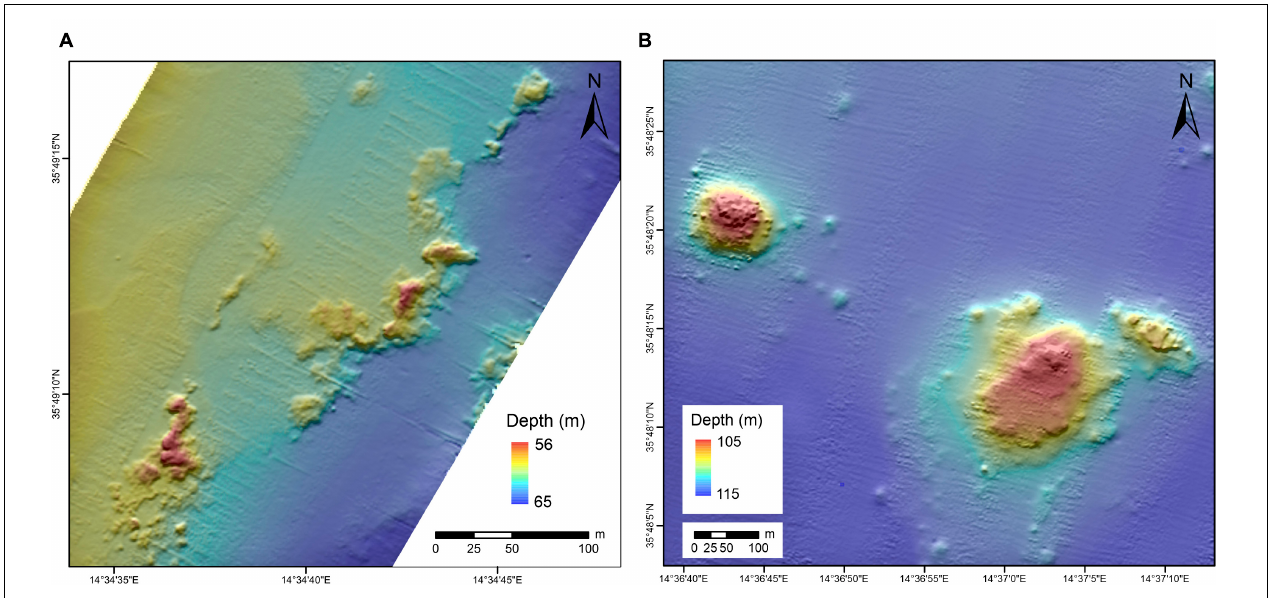
FIGURE 4 | Bathymetric maps of the mounds. (A) Case example for mounds in the 40–83 mbspl clusters and (B) case example for mounds in the 83–120 mbspl cluster.